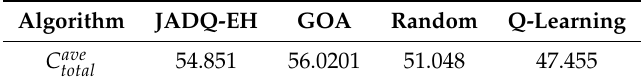
Table 4. C ave comparison of different algorithms under scenario total